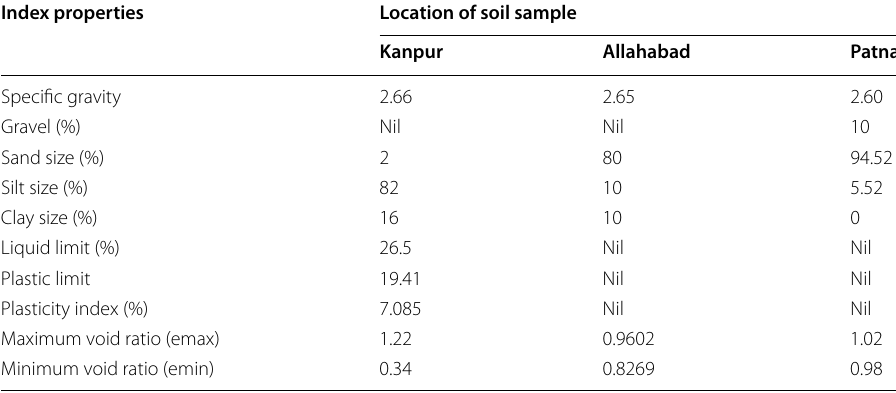
Table 1 Index properties of the soil used in this present